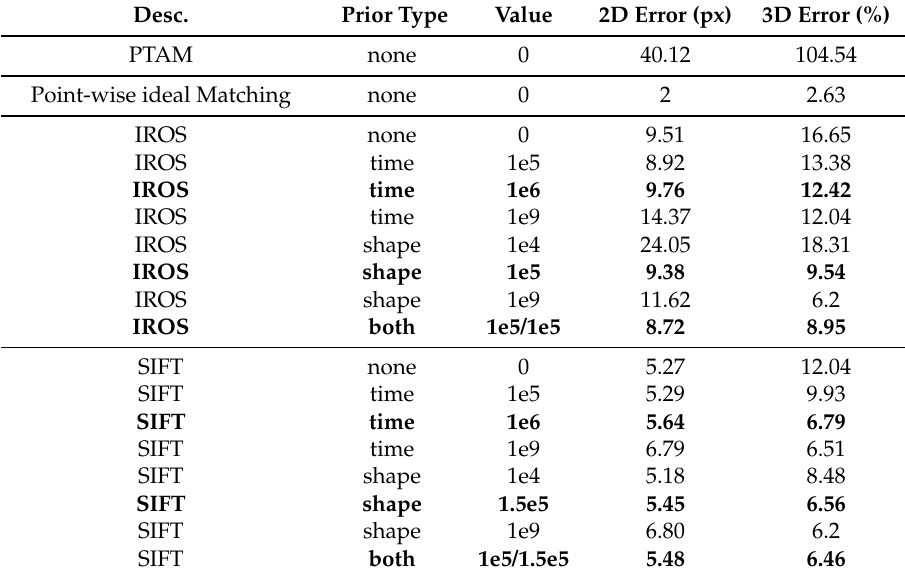
Table 6. Summary of the results for the rendered flag sequence with different numbers of bases, priors and